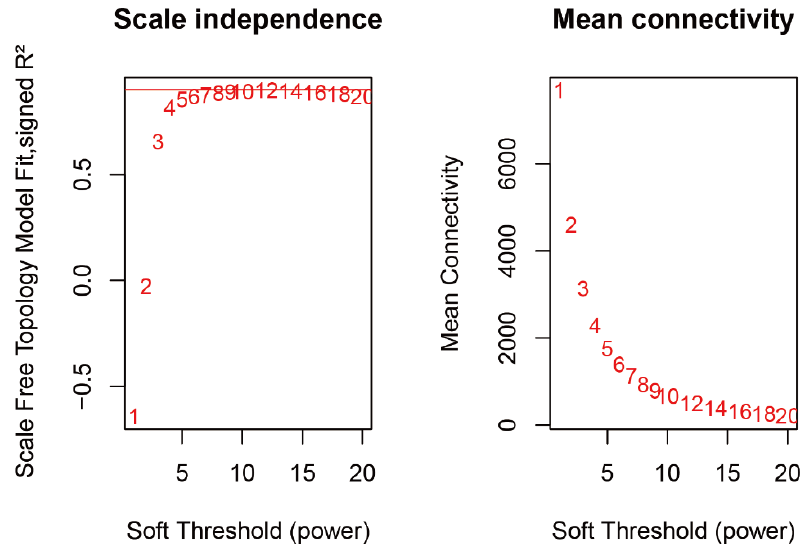
Figure A6. Approximate scale-free topology.